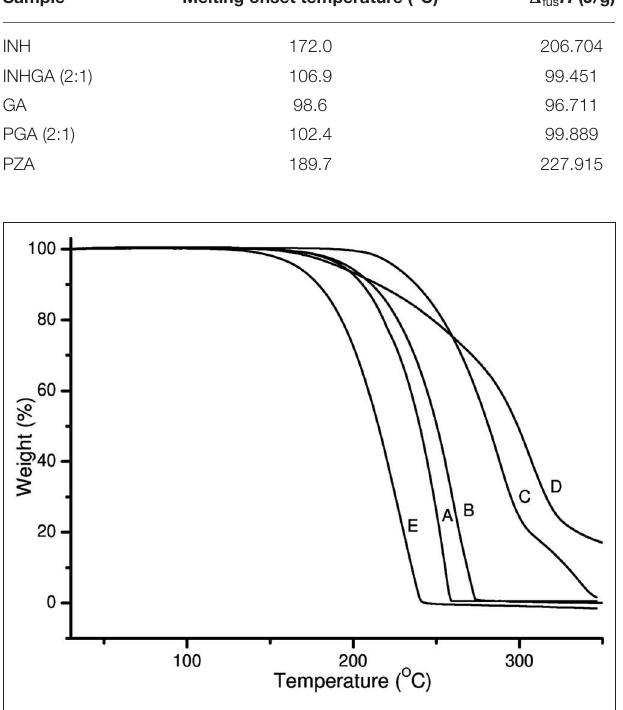
FIGURE 3 | TGA thermograms of (A) PZA, (B) GA, (C) INH, (D) INHGA (2:1) and (E) PGA (2:1)